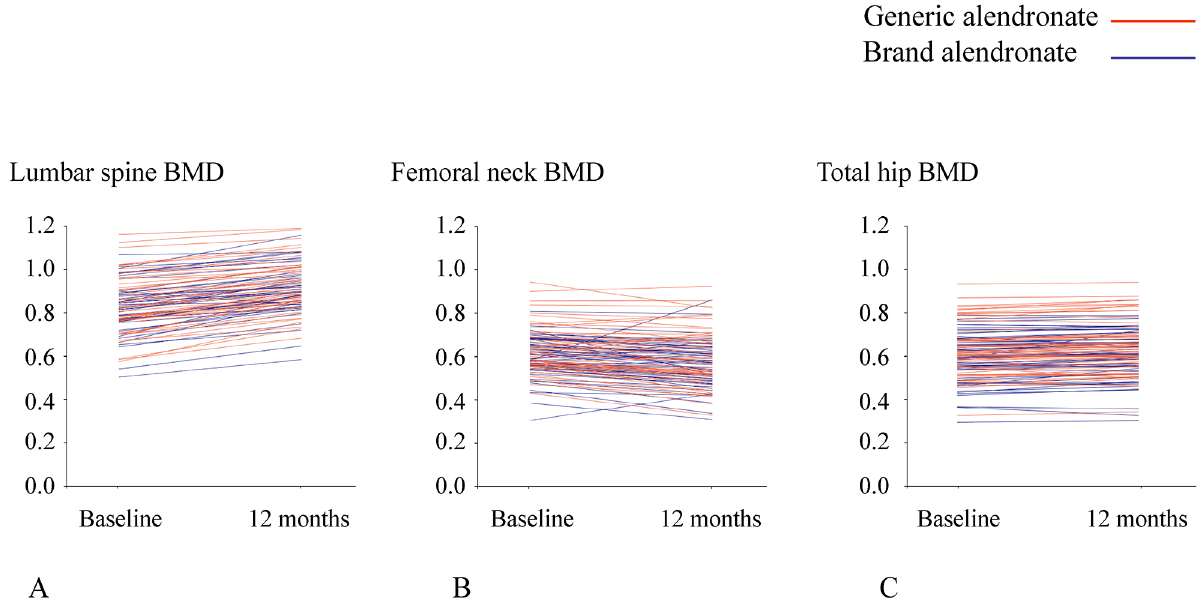
Fig 2. “Spaghetti plot” graphs showing changes in BMD for each patient at the (A) lumbar spine, (B) femoral neck, and (C) total